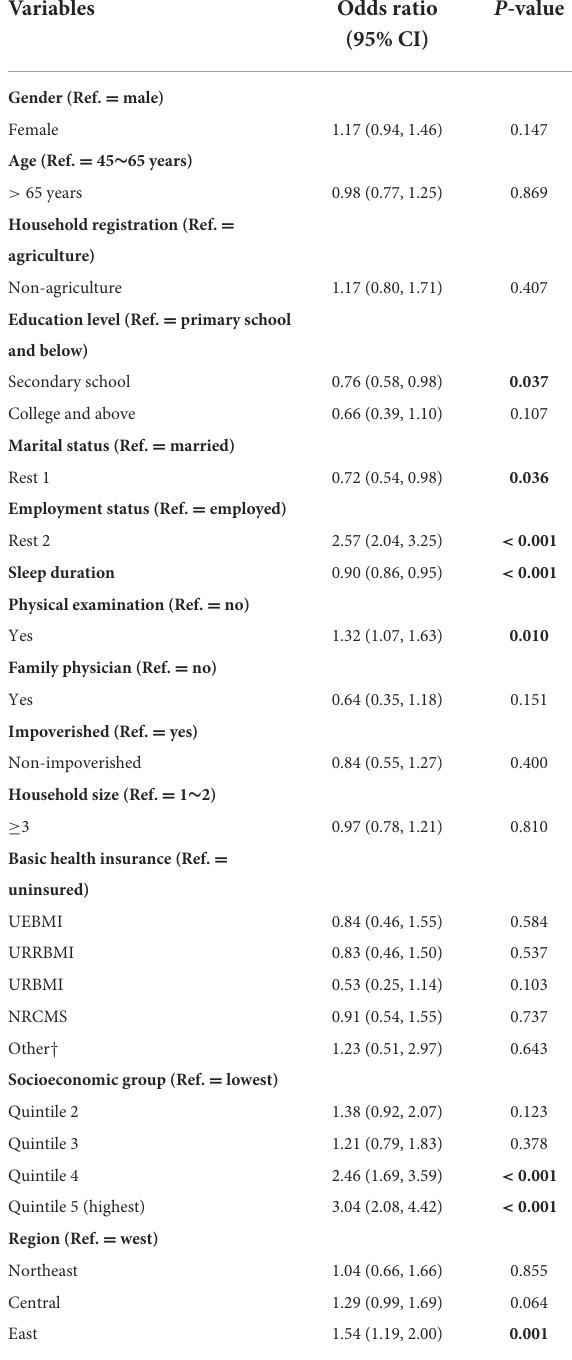
TABLE 2 Cancer determinants among people aged 45 years and older in China,